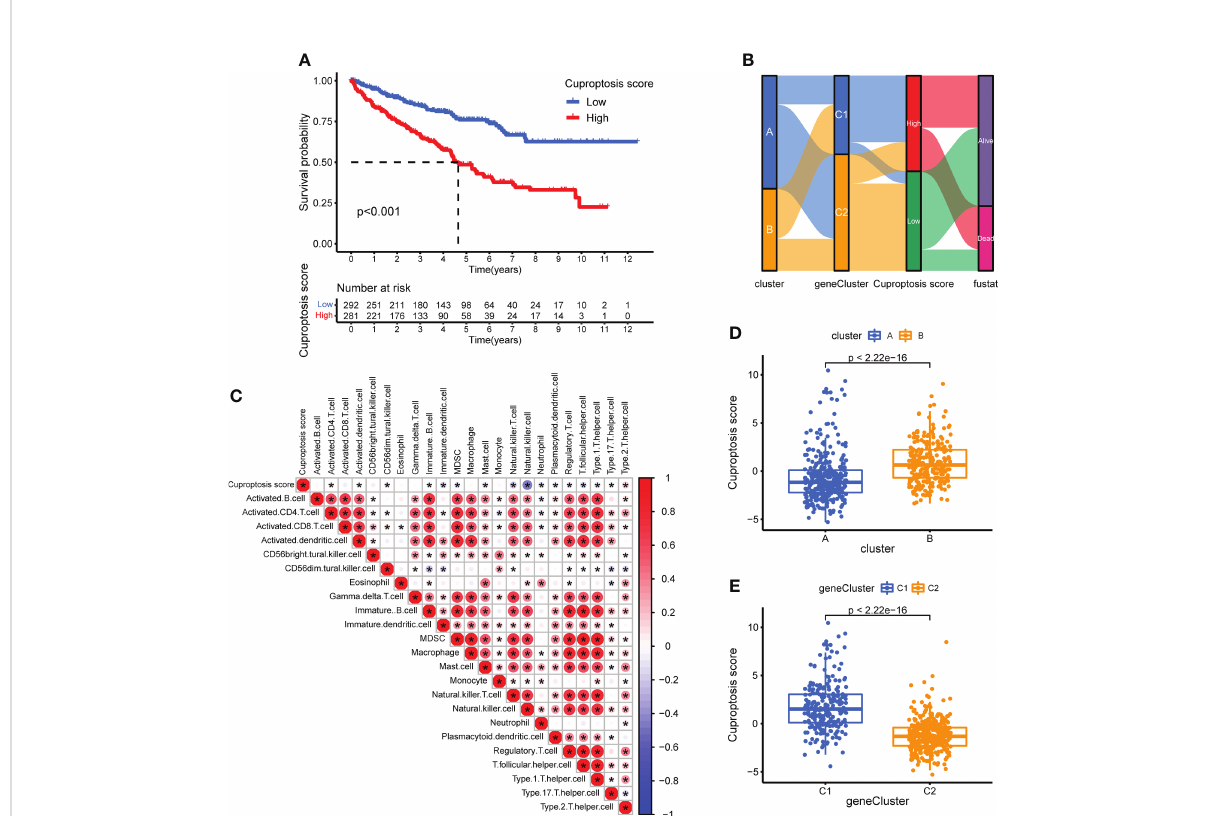
FIGURE 7 Construction of CUS and grouping based on score. (A) Kaplan – Meier survival analysis between the high- and low-CUS groups (OS, Log-rank test, p < 0.001). (B) Sankey diagram of subtype distributions in groups with different CUSs and survival outcomes. (C) The correlation matrix of cuproptosis and all 22 in fi ltrating immune cells. Red means positive correlation, whereas blue means negative correlation. p < 0.05 was the cut- off. (D) Differences in CUS levels between the two CPG subtypes. (E) Differences in CUS levels between the two CSRG gene subtypes. CUS, cuproptosis score; CPG, cuproptosis-promoting gene; CSRG, cuproptosis subtypes related gene; *p <